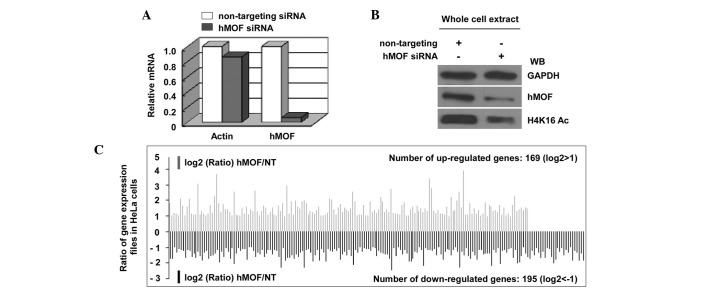
Gene expression profiles in hMOF siRNA knockdown HeLa cells. (A) Relative mRNA levels markedly decreased following the specific knockdown of hMOF. The HeLa cells were transfected with hMOF siRNAs or a non-targeting (NT) control siRNA. At 48 h post-transfection, hMOF mRNA levels were measured by qPCR. Actin mRNA was used to assess the integrity of the RNA. (B) hMOF protein expression and its corresponding modifications were down-regulated by transfecting HeLa cells with hMOF siRNAs. Equivalent total protein amounts of whole cell extracts from the cells treated with hMOF siRNAs or NT siRNAs were subjected to SDS-PAGE in 12% gels, and the proteins were detected by western blotting using the indicated antibodies. (C) Gene expression profiles in hMOF siRNA knockdown HeLa cells. The gray bars represent the upregulated genes (log2>1), while the black bars represent the downregulated genes (log2<−1). Each bar is the log2 value of the ratio of gene expression in hMOF siRNA knockdown HeLa cells. hMOF, human males absent on the first; qPCR, quantitative polymerase chain reaction; H4K16, histone H4 lysine 16; WB, western blotting.